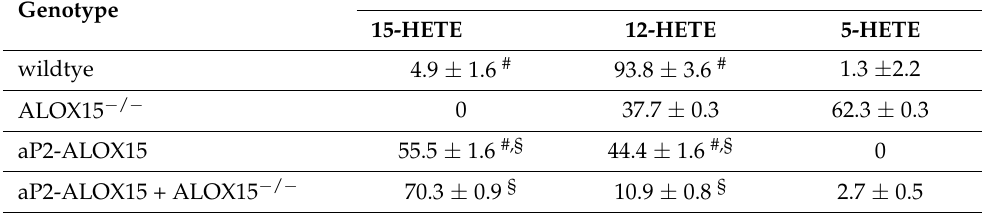
Table 2. Ex vivo activity assays of bone marrow cells prepared from mice of different genotype. 5 × 10 7 bone marrow cells prepared from mice of different genotype (n = 3 of each genotype) were incubated with exogenously added arachidonic acid as described in Section 4. The arachidonic-acid- derived oxygenation products were prepared and further analyzed by RP-HPLC (see Section 4). Statistical evaluation of the experimental raw data was performed using the Student’s t-test